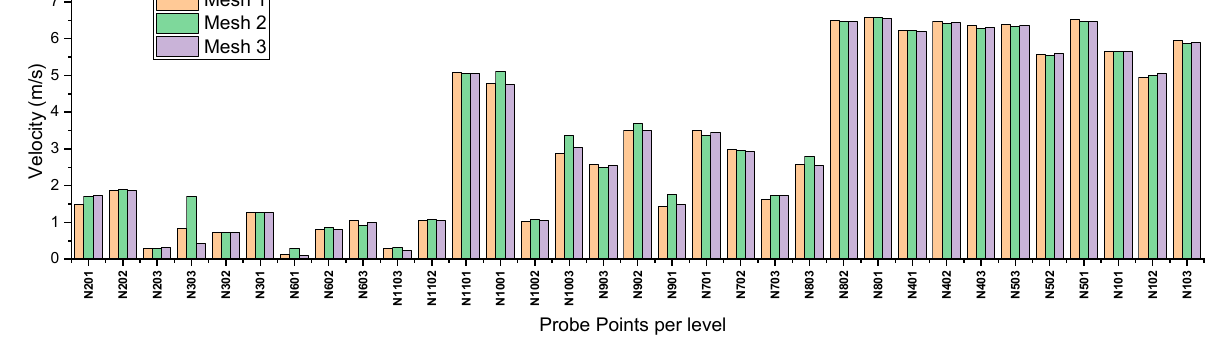
Figure 16. Mesh independence study considering three different meshes for the OpenFOAM computational domain. Velocity in validation points. Hypothetical vertical wind profile considered.